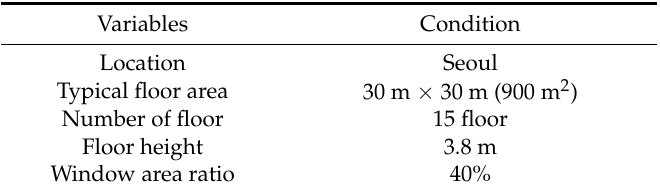
Table 3. Standard specifications set for the design of office building.